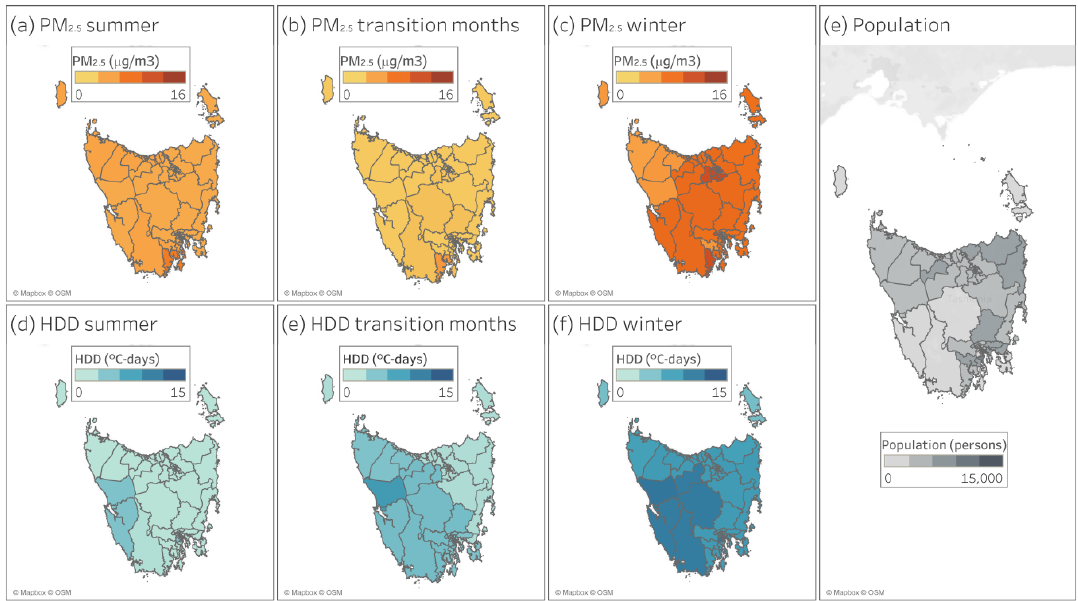
Figure 1. Average summer, transition, and winter months fine particulate matter (PM 2.5 ) concentration and heating degree days (HDD) and exposed population.